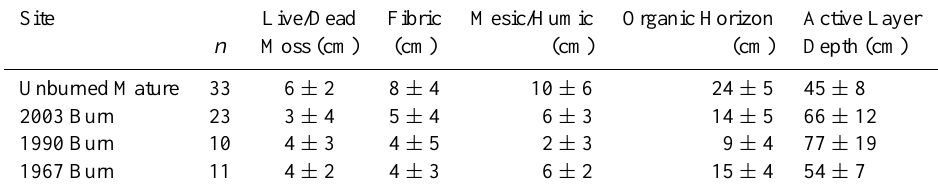
Table 2. Organic horizon thicknesses and active layer depths across upland fire